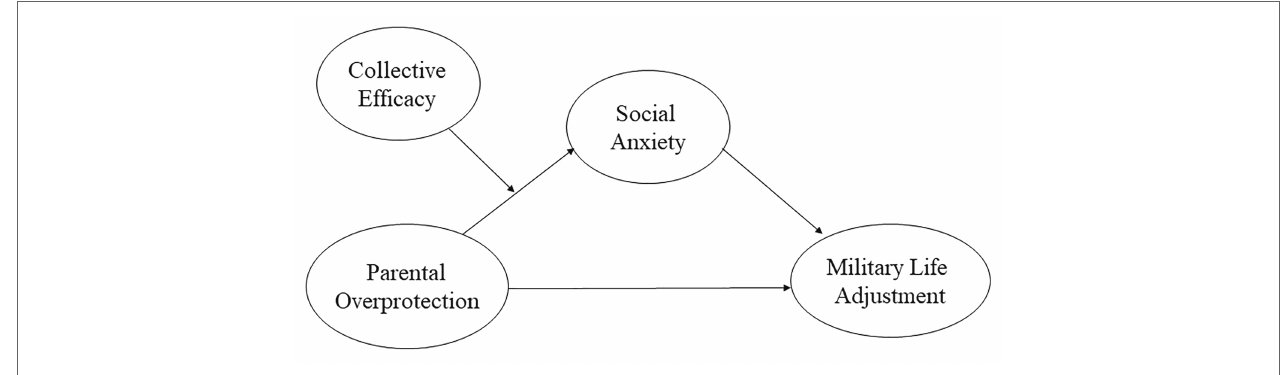
FIGURE 1 | Hypothesized model of the relationships among parental overprotection, social anxiety, collective efficacy, and military life